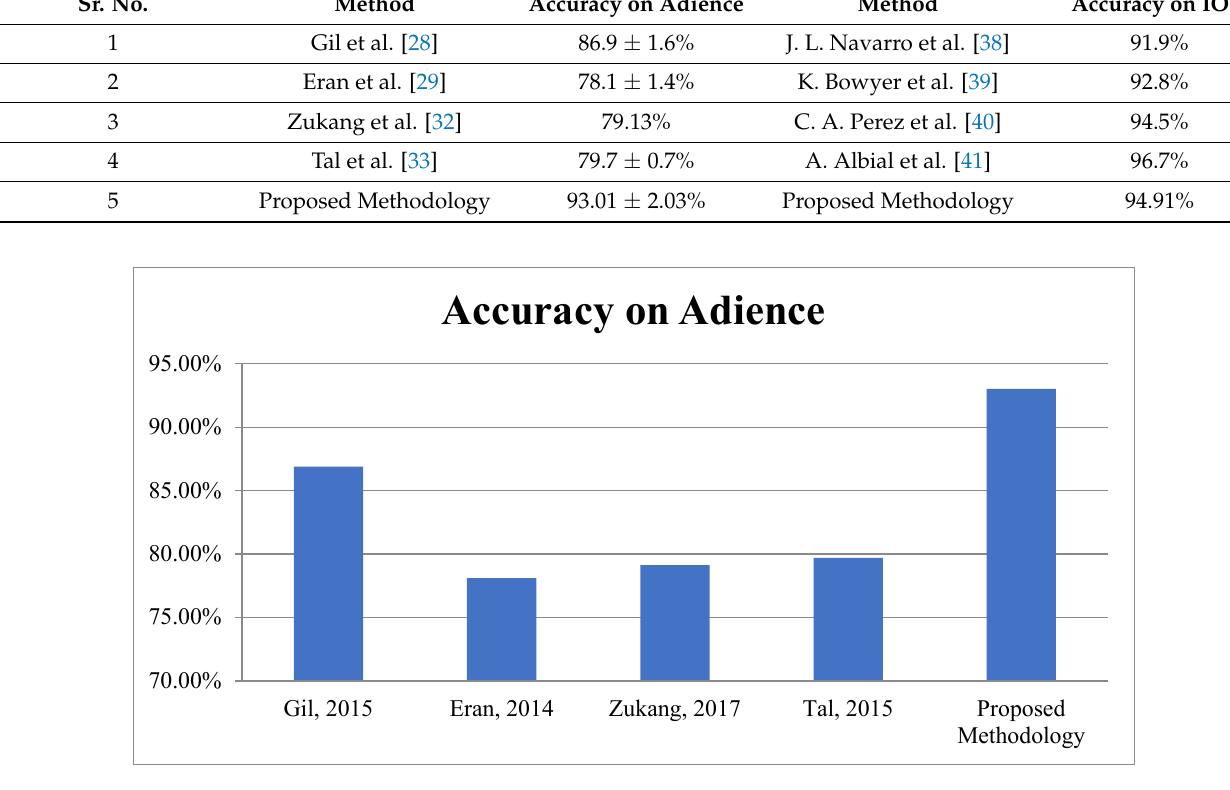
Figure 15. Accuracy Comparison for Gender Classification on Adience.